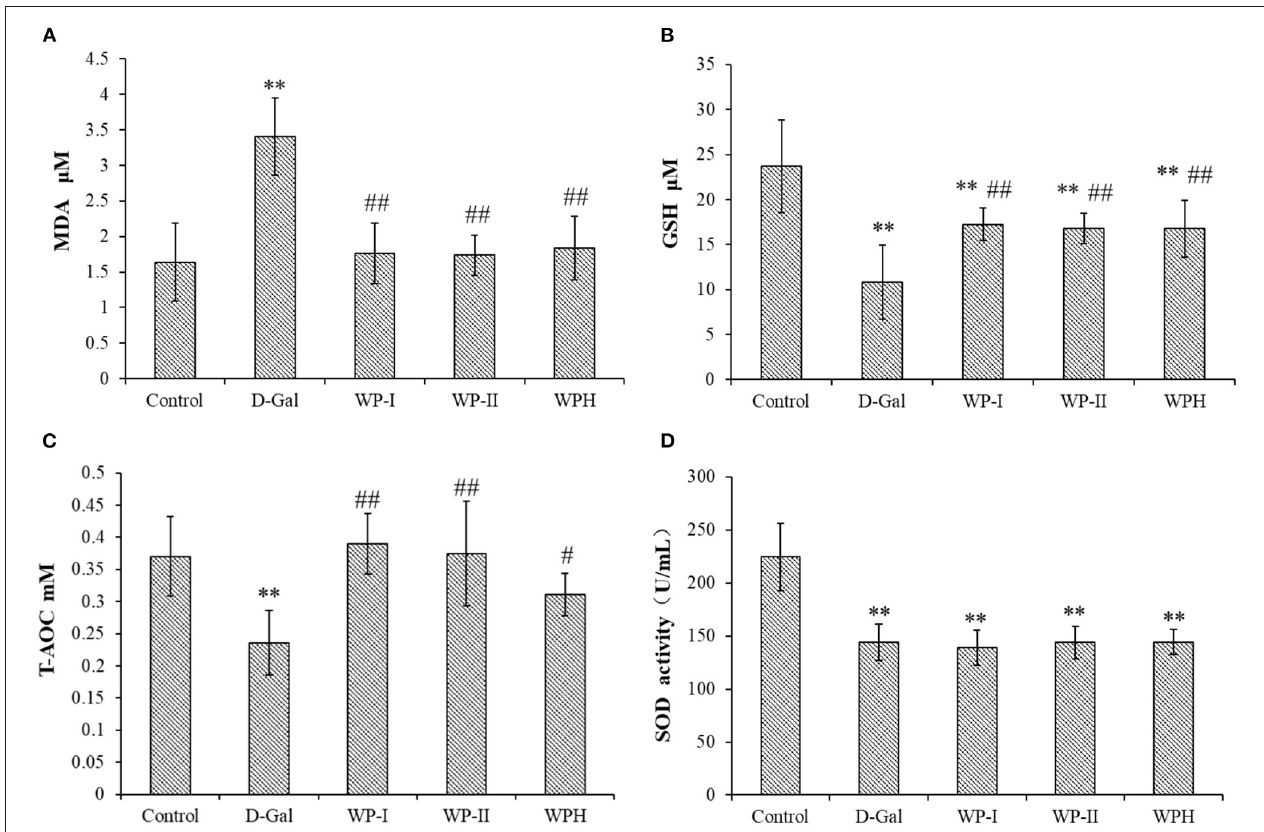
FIGURE 6 | Effect of walnut protein and its hydrolysate on serum biochemical indexes in D-galactose-induced oxidative damage rats. (A) MDA; (B) GSH; (C) T-AOC and (D) SOD. **means significantly different ( p < 0.01) compared to the control group. # significant differences ( p < 0.05) and ## significant differences ( p < 0.01) vs. the D-Gal group, respectively. Control represents the normal control group (saline); D-Gal represents the model control group (D-galactose); WP-I and WP-II represents the low dosage and high dosage of walnut protein group, respectively; WPH represents the walnut protein hydrolysate